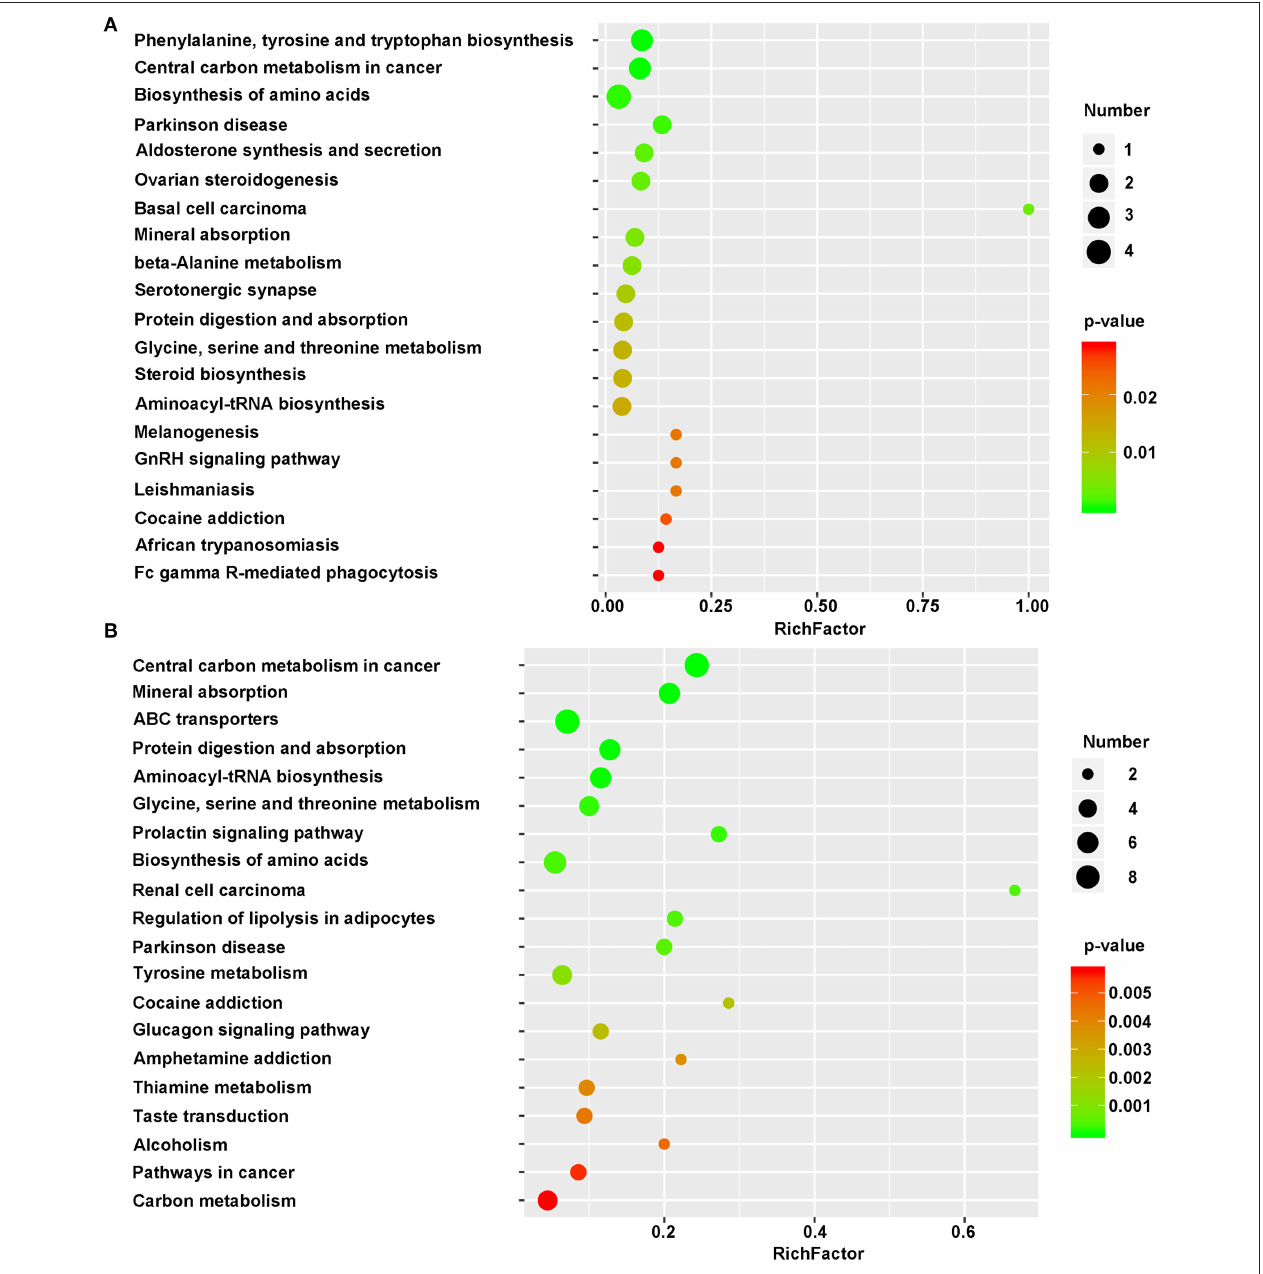
FIGURE 5 | Bubble diagram of differential metabolic pathways. One bubble represent one metabolic pathway. Top 20 pathways were list in left side. Numbers of involved metabolites and the p -value were list on right side. (A) Bubble diagram of 2DG vs. TCPS. (B) Bubble diagram of 3DG vs. 2DG. X-axis represent rich factor. This figure was drawn using R